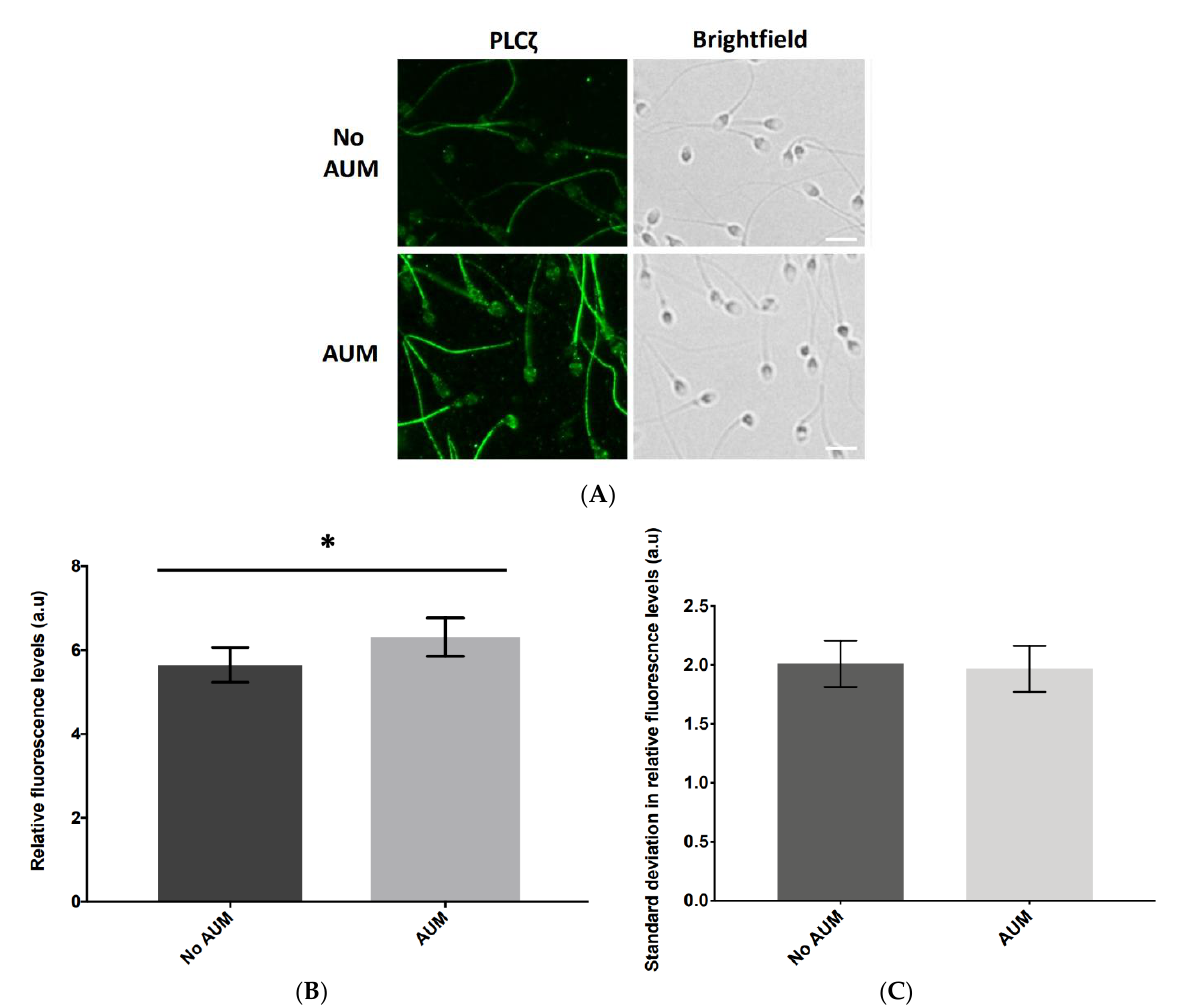
Figure 3. ( A ) Representative immunofluorescence images of observed PLCζ relative fluorescence in human sperm without and with antigen unmasking (no AUM and AUM, respectively), indicating ( B ) the increase in observable fluorescence following AUM which was significantly higher than the fluorescence observed without AUM. ( C ) Histogram indicating the change in the average variation of relative fluorescence levels of PLCζ (measured by average standard deviation , SD) with (light bars) and without (dark bars) antigen unmasking (AUM and no AUM, respectively). Asterisks (*) indicate a statistically significant ( p ≤ 0.05) difference. Data are indicative of 100 cells examined from three technical repeats of sperm each obtained from 55 patients, for both no AUM and AUM treatments. Images were captured at 40× magnification and white scale bars represent 10 μm.